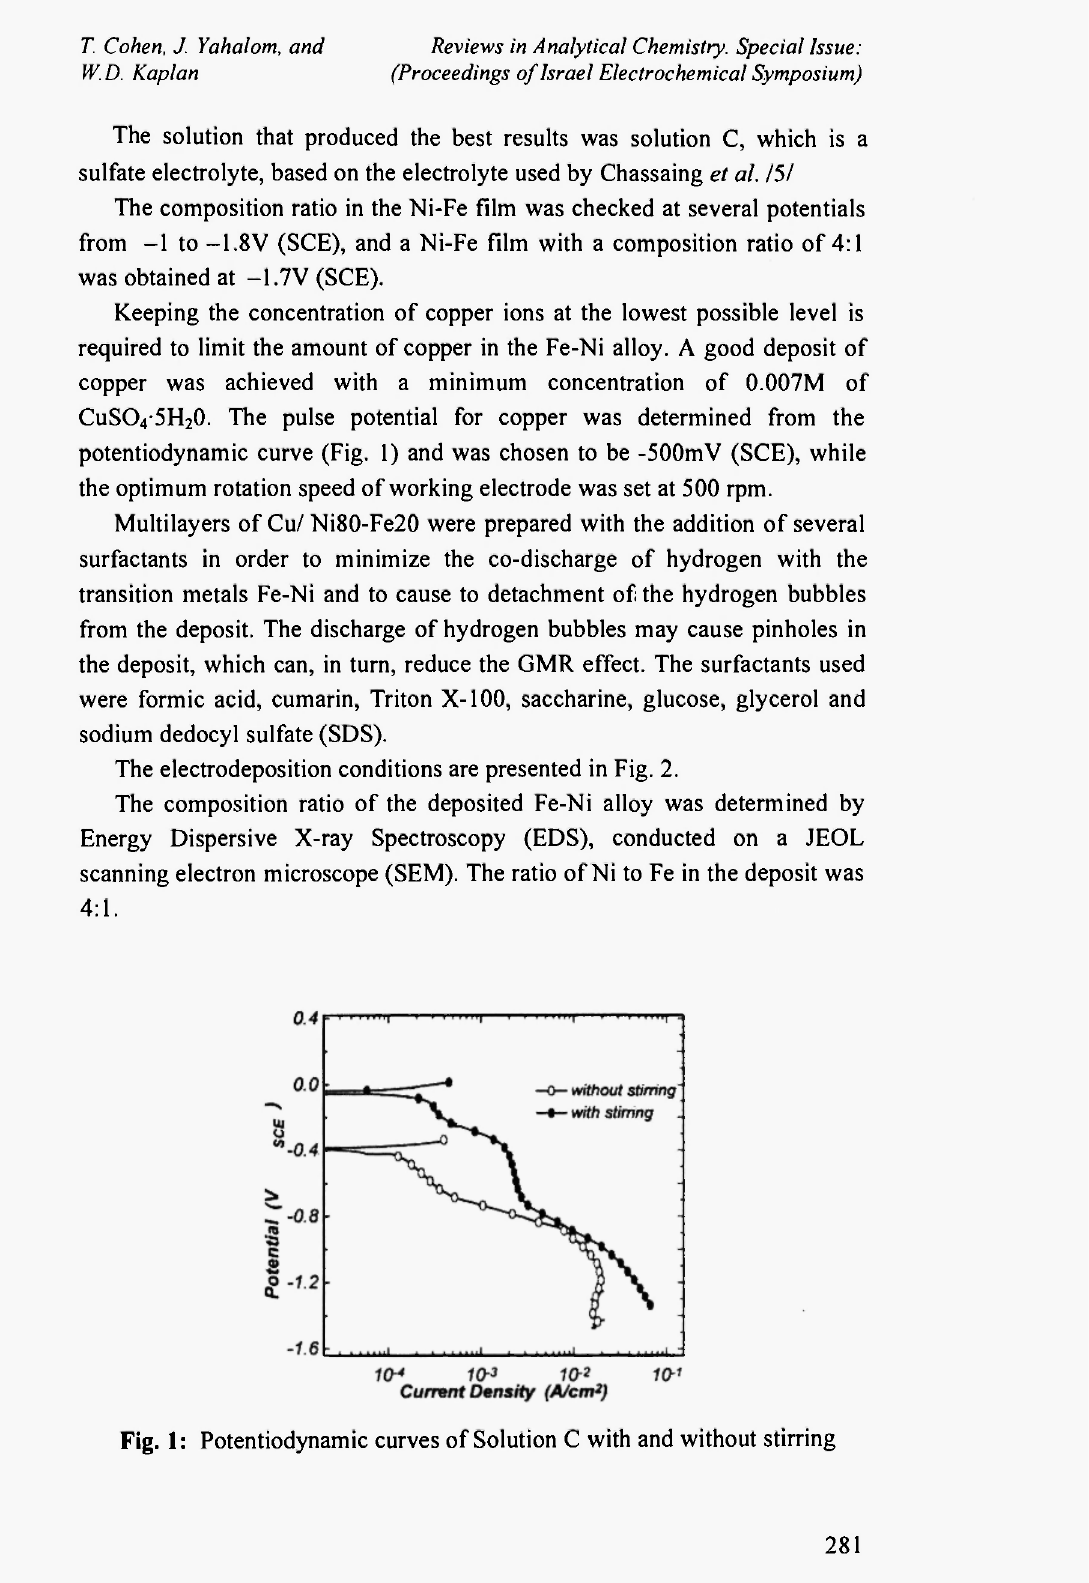
Fig. 1 : Potentiodynamic curves of Solution C with and without stirring